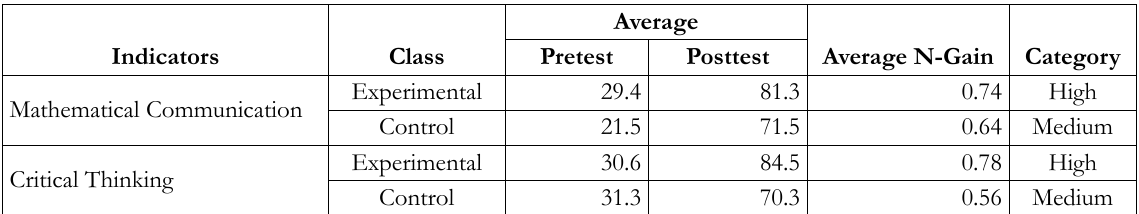
Table 6. Results of the analysis of N-Gain